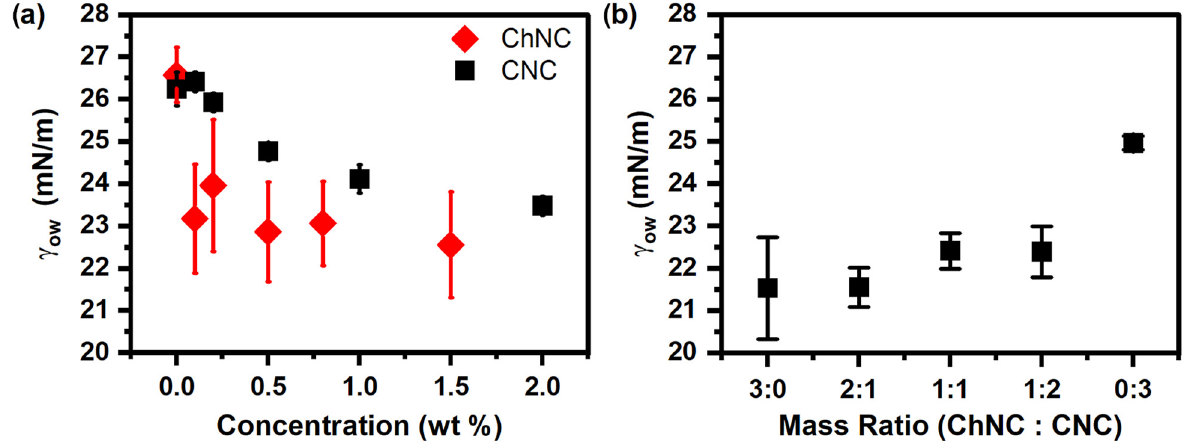
Figure 5. Interfacial tension ( γ ow ) between soybean oil and 20 mM NaCl solutions as a function of ( a ) CNC and ChNC concentration and ( b ) ChNC:CNC mass ratio. Both ChNC and CNC lower γ ow by 4 and 3 mN/m, respectively, while addition of CNC to ChNC increases the γ ow .